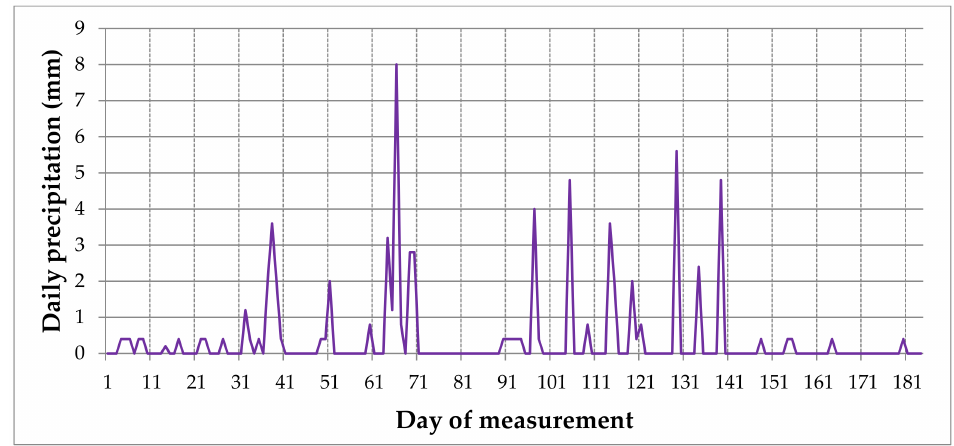
Figure 7. Daily variations of precipitation during the measurement